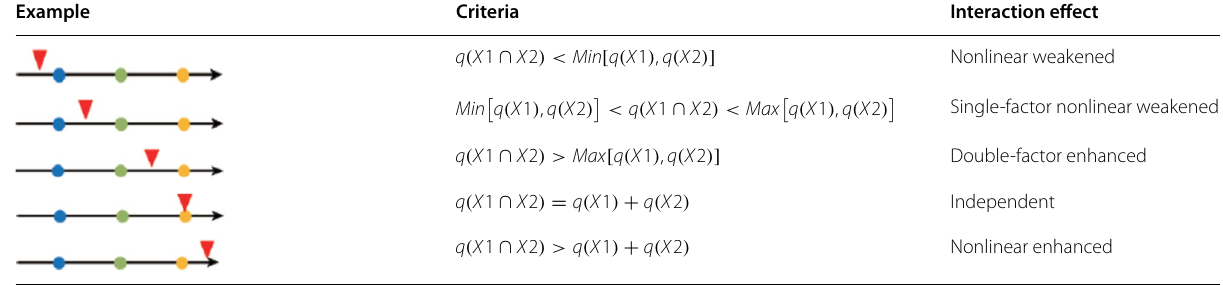
Table 1 Interaction detector Example Criteria Interaction